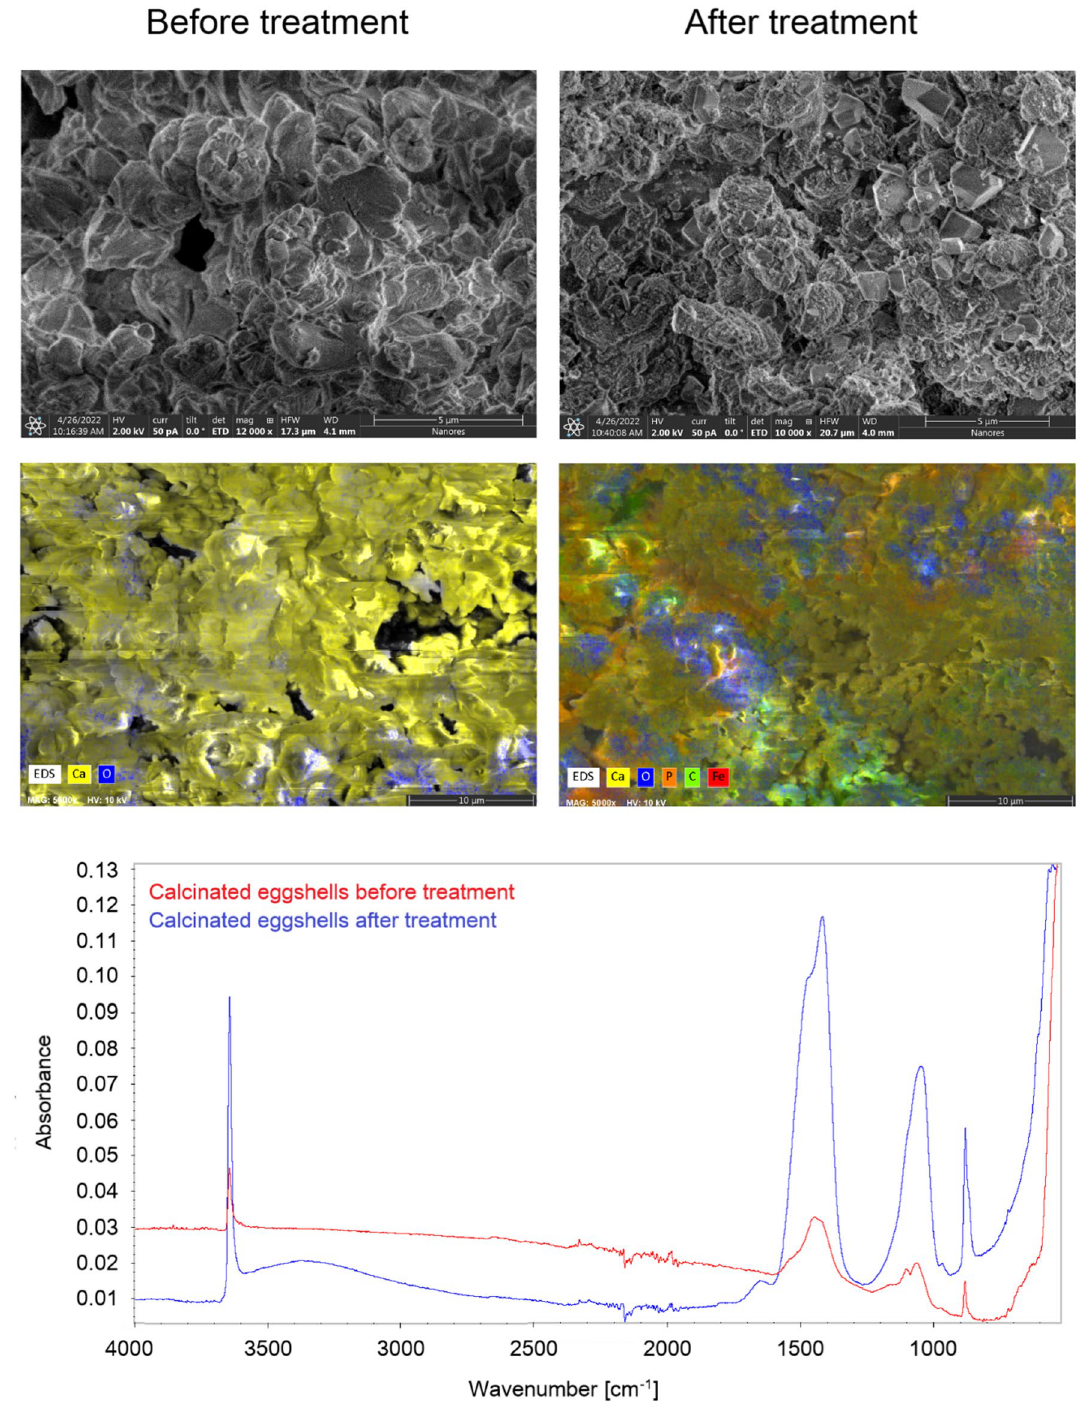
Figure 7. FT-IR spectra and SEM with EDS images of calcinated eggshells before and after